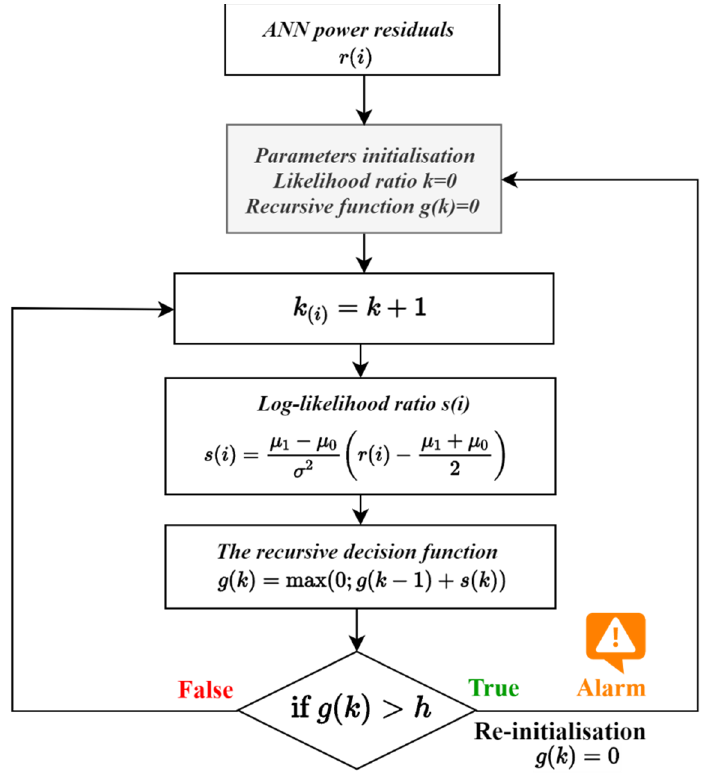
Figure 11. CUSUM change detection algorithm flow chart.